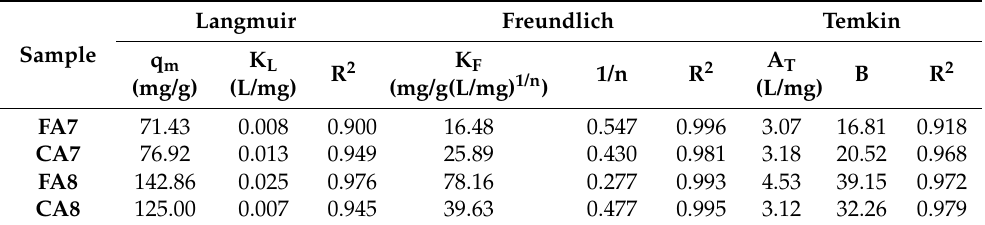
Table 4. The parameters calculated from Langmuir, Freundlich and Temkin models. Sample